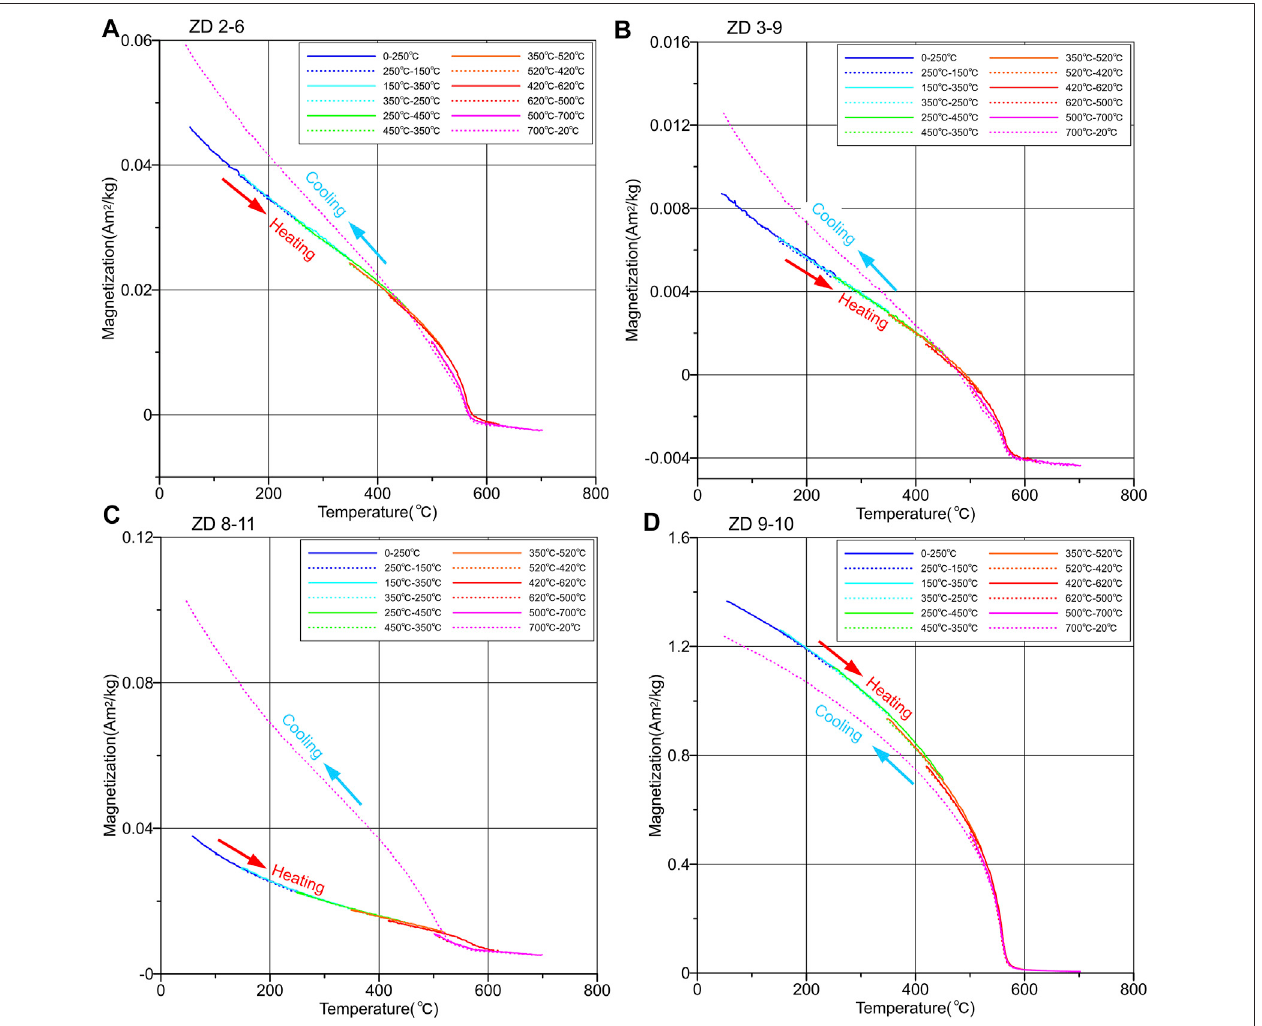
FIGURE 4 | (A – D) High- fi eld thermomagnetic runs of representative samples from the Zaduo granite. Solid (dashed) lines indicate the heating (cooling) curves.